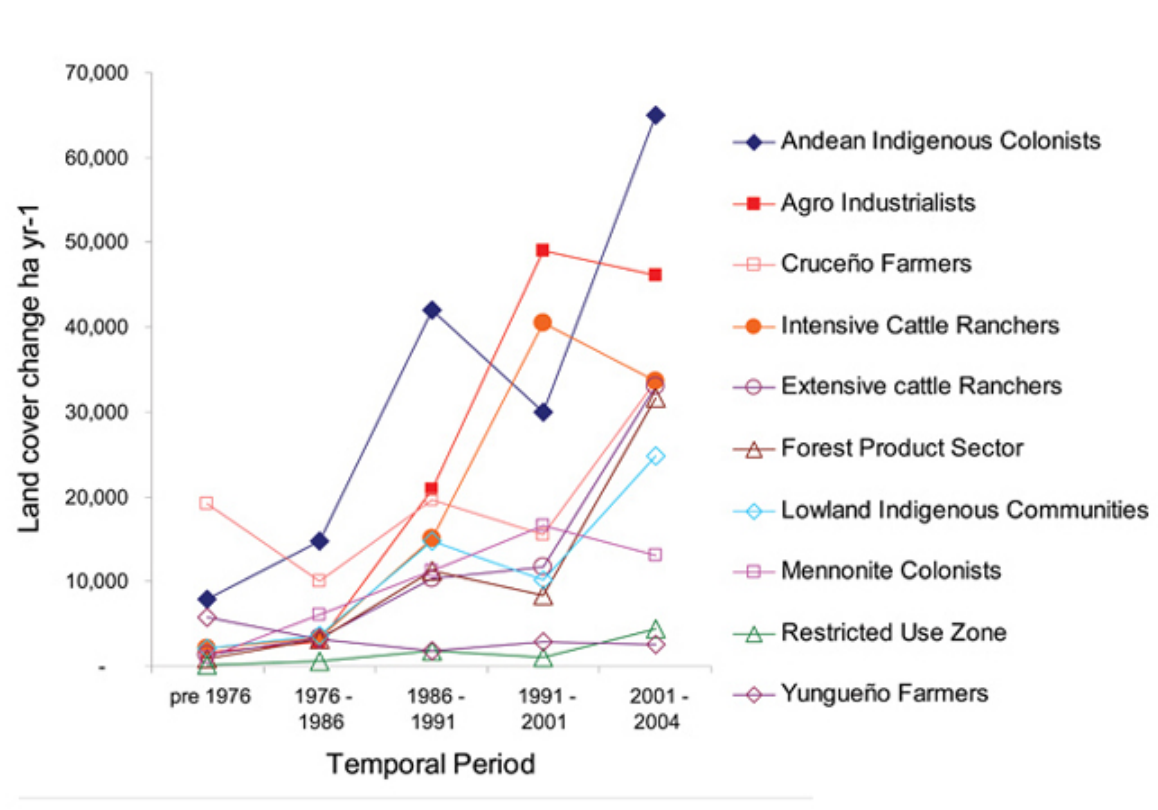
Fig. 3. The temporal variation in land-cover change among social and economic groups in eastern Bolivia reflects differences in global markets, the national economy, government policies, and migratory phenomena characteristic of individual